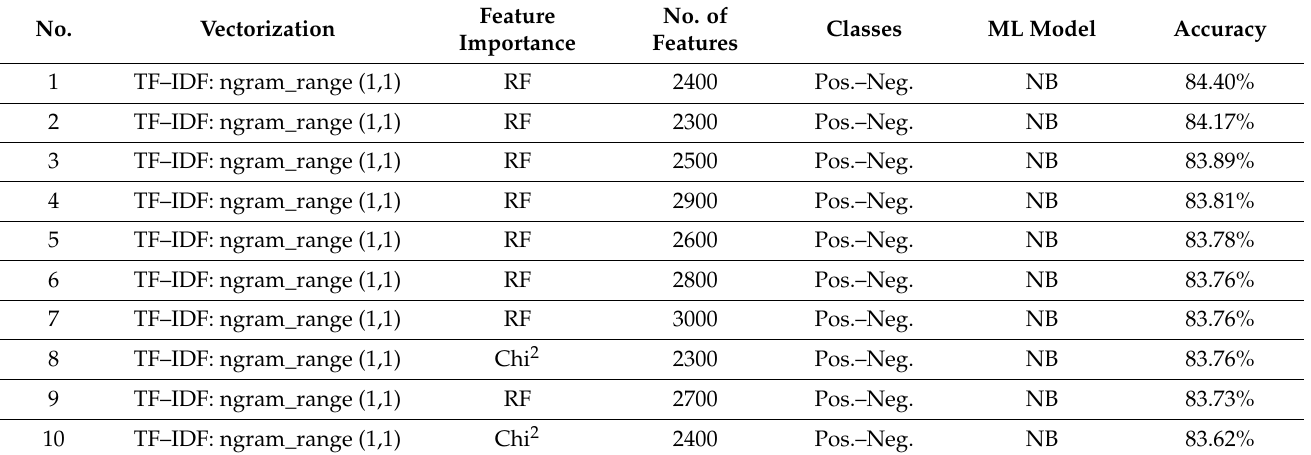
Table 6. Top 10 accuracies for feature importance